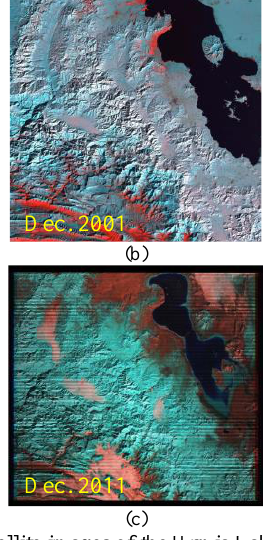
Figure 1. Satellite images of the Urmia Lake in (a) 1989, (b) 2001 and, (c) 2011: These images obviously show the negative trend of water level and gradually shrinking of the lake area through 22 years (source: U.S. Geological Survey).